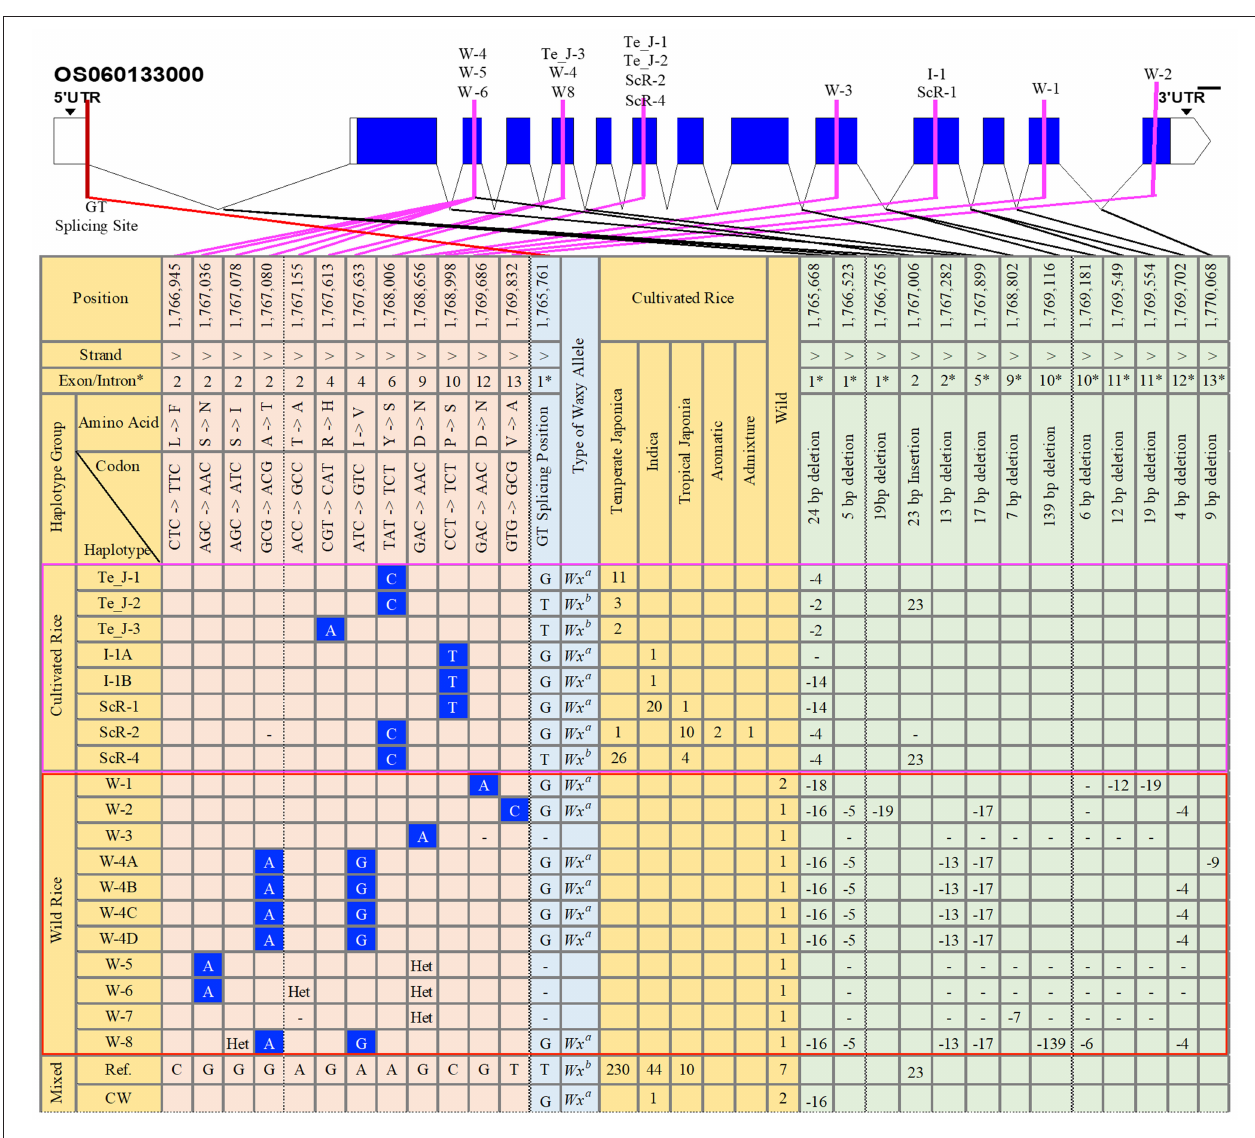
FIGURE 1 | Gene structure and haplotype analysis of the granule-bound starch synthase I ( GBSSI ) ( Os06g0133000 ) gene in 475 accessions of the Korean rice collection. The haplotypes were grouped into cultivated rice, wild rice, and mixed (cultivated rice and wild rice). Orange-colored columns provide the list of haplotypes together with their respective numbers of rice accessions in each subpopulation. Light-blue-colored columns indicate the corresponded waxy alleles based on the possession of a “G” or “T” nucleotide at the G-T splicing site of intron 1. Light-orange-colored columns indicate all single nucleotide polymorphism (SNP) variations found only at non-synonymous mutation sites. Light-green-colored columns represent variation sites for InDels. Blank cell indicates major alleles in that position. “Het” refers to “heterozygote,” and a dash (-) indicates the position for an “unknown” nucleotide or generally refers to “N” (any nucleotide A, T, G, or C). CW, cultivated and wild; Te_J, temperate japonica; I, indica; ScR, subcultivated rice; W, wild rice; Ref., reference. The selected number of chromosome positions and sorted haplotypes were based on the findings for functional SNPs